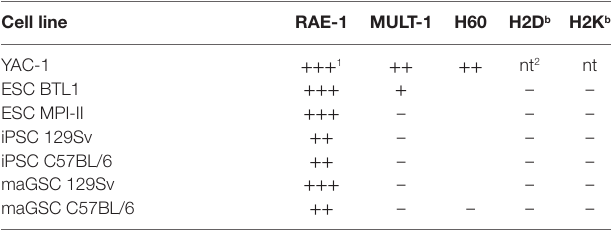
TaBle 2 | Summary of the expression of NKG2D ligands and major histocompatibility complex class I molecules on pluripotent stem cells and